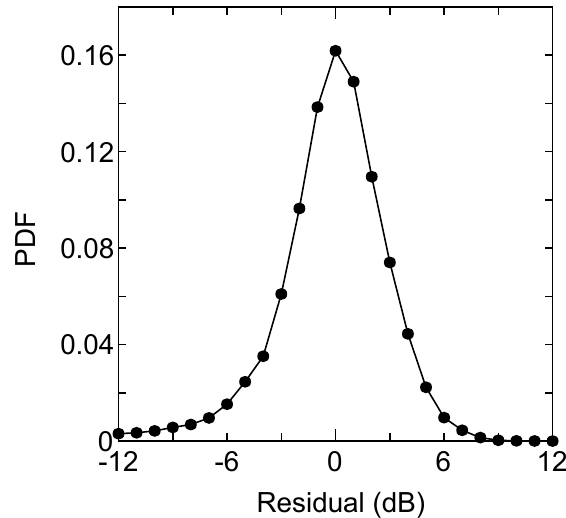
Figure 8. Probability density function of the shadowing